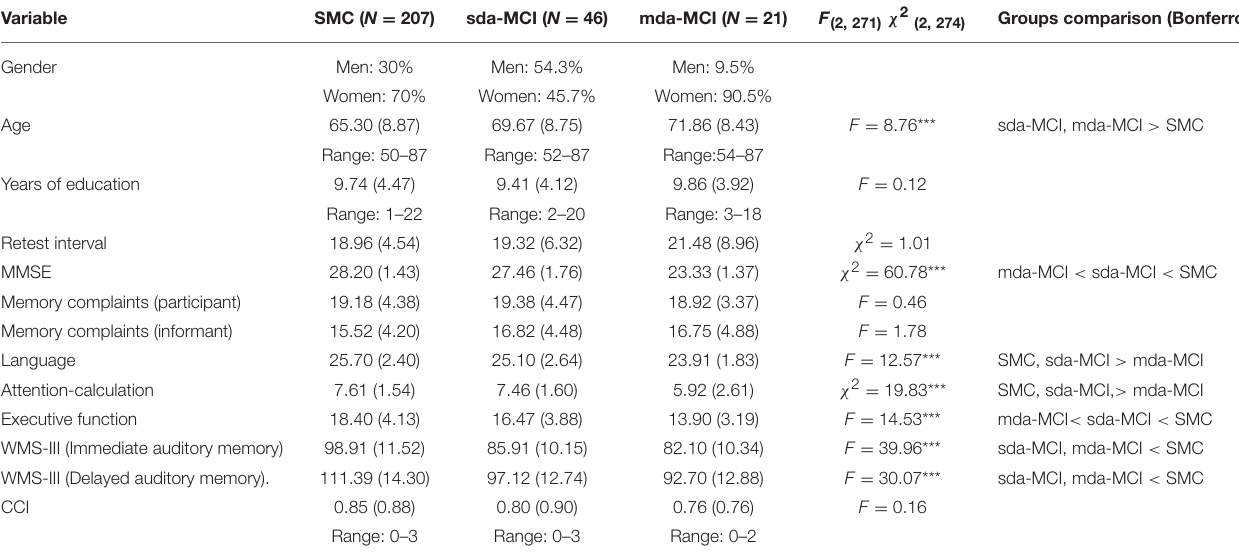
TABLE 1 | Mean scores (and standard deviations) for demographic and neuropsychological variables obtained at Time 1 by the different study groups: single domain amnestic mild cognitive impairment (sda-MCI), multiple domain amnestic mild cognitive impairment (mda-MCI), and a group with subjective memory complaints without cognitive impairment